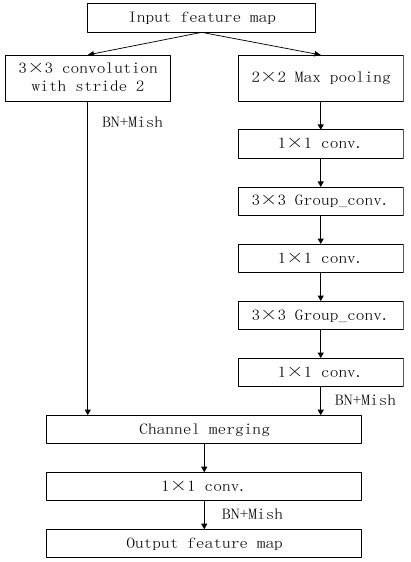
Figure 4. The down-sampling attention module.